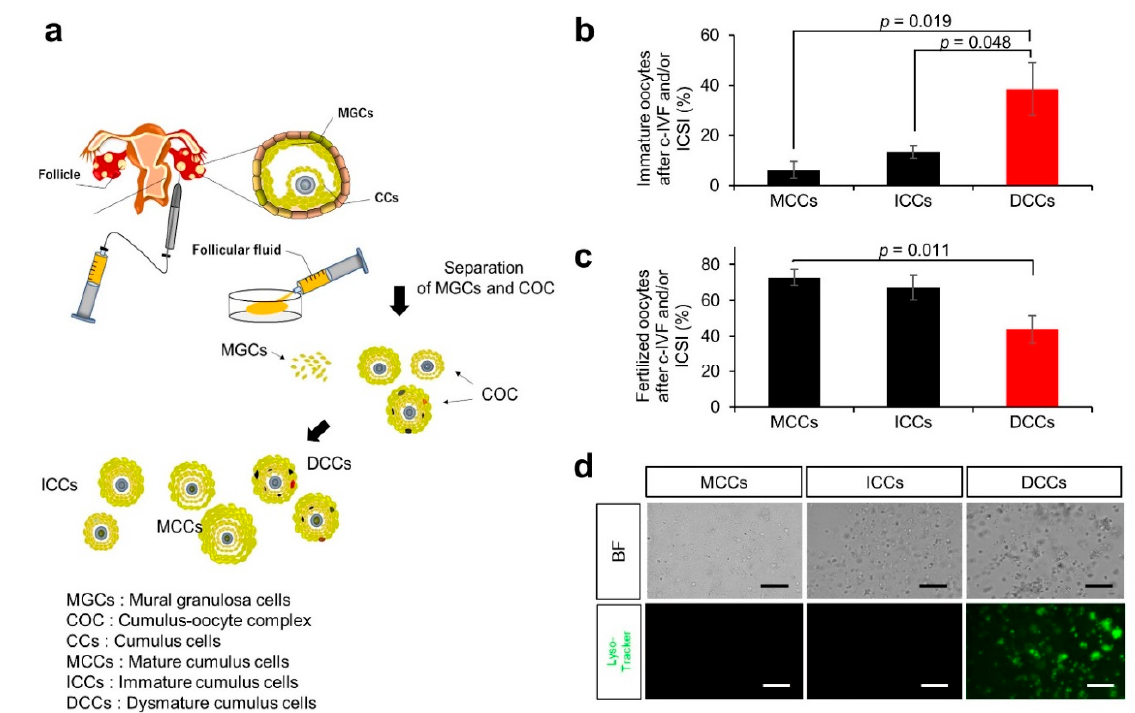
Figure 1. Experimental flow for collecting samples and fertilization rate by the maturity of cumulus cells. ( a ) Flow chart of collecting cumulus cells from cumulus-oocyte complex (COC). COCs were retrieved from stimulated follicles by hormones, and human granulosa cells (MGCs) and COCs were isolated from follicular aspirates. The maturity of COCs was evaluated based on morphologic criteria. Evaluated cumulus cells were physically detached from COCs. Obtained cumulus cells were used in experiments and oocytes were used for ART by IVF or ICSI. ( b ) Percentage of immature oocytes after c-IVF and/or ICSI in oocytes separated from MCCs, ICCs, and DCCs (black bars; MCCs and ICCs, red bar; DCCs). Values are indicated as the mean ± SE. ( c ) Fertilization rate of oocytes after c-IVF and/or ICSI in oocytes separated from MCCs, ICCs, and DCCs (black bars; MCCs and ICCs, red bar; DCCs). Values are indicated as the mean ± SE. ( d ) Staining with LysoTracker. BF, bright field. Scale bar, 50 μ m.